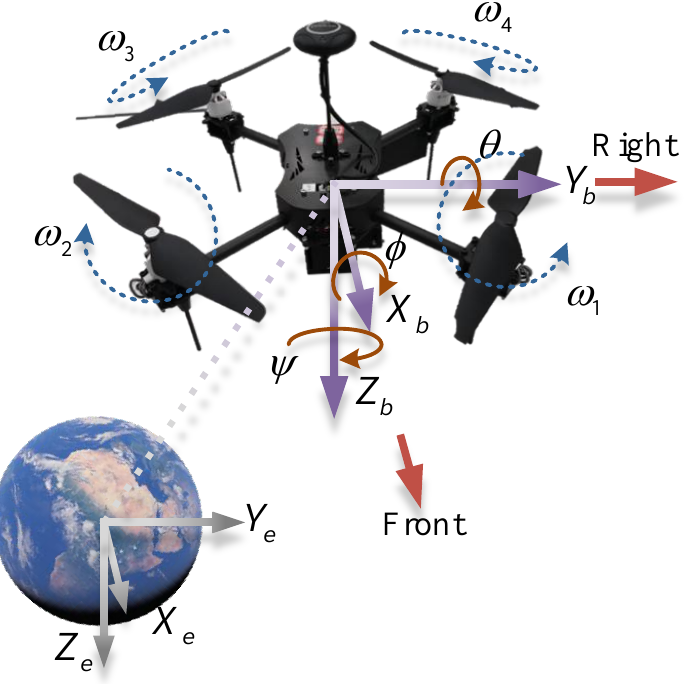
Figure 1. Intuitive representation of the Euler angle for QUAV. As rendered in Figure 1, φ , θ and ψ refer to the roll, pitch and yaw angle, respectively. Correspondingly, they are defined as the rotation angle of the body coordinate system around x b , y b and z b axes. Rolling to the right, up along the nose and yawing to the right are denoted as the positive